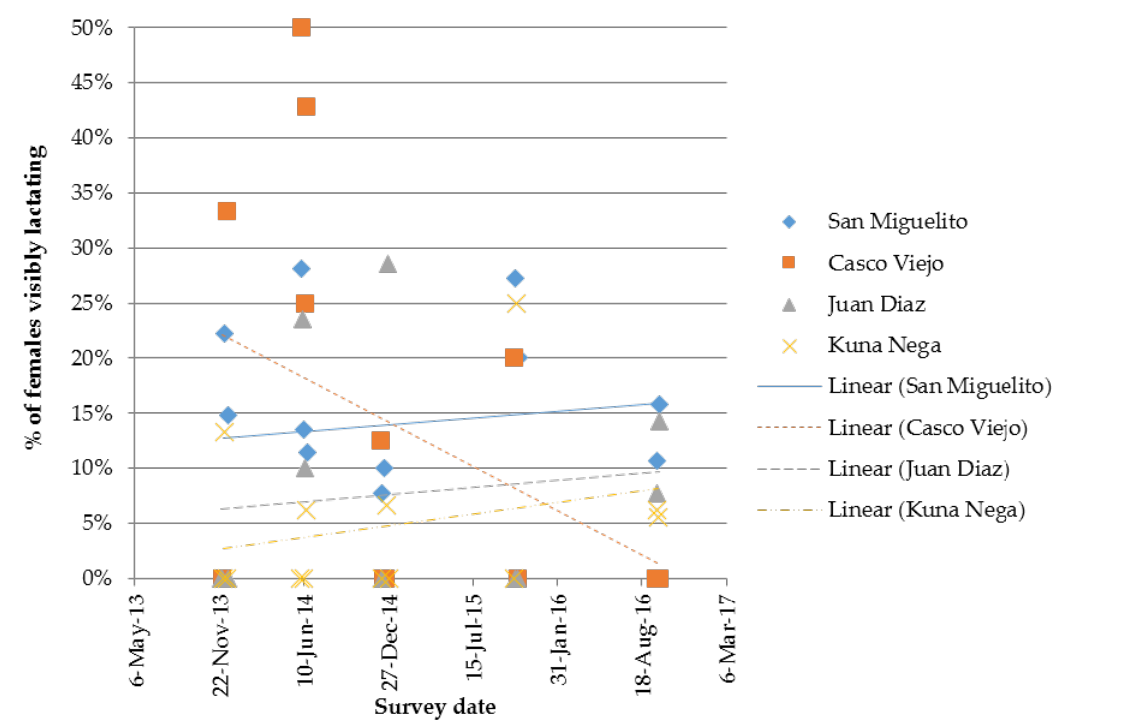
Figure 5. Percentage of females lactating at the time of observation; percentage for each of the four Panama City routes, at each survey event (comprised of two or three replicate surveys per route).